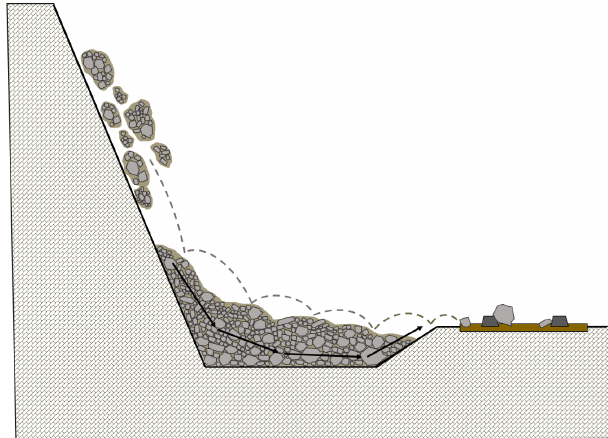
Figure 9. Schematic of potential fragmental rockfall runout be- haviour. Here leading material from the event has filled up a catch- ment ditch. Trailing rockfall material impacting the back of the de- posit has the potential to push the leading material forward and out of the ditch (black arrows) reaching the track area. Additionally, the initial material has created a surface over which trailing rock frag- ments can move (grey trajectory), reducing the effectiveness of the